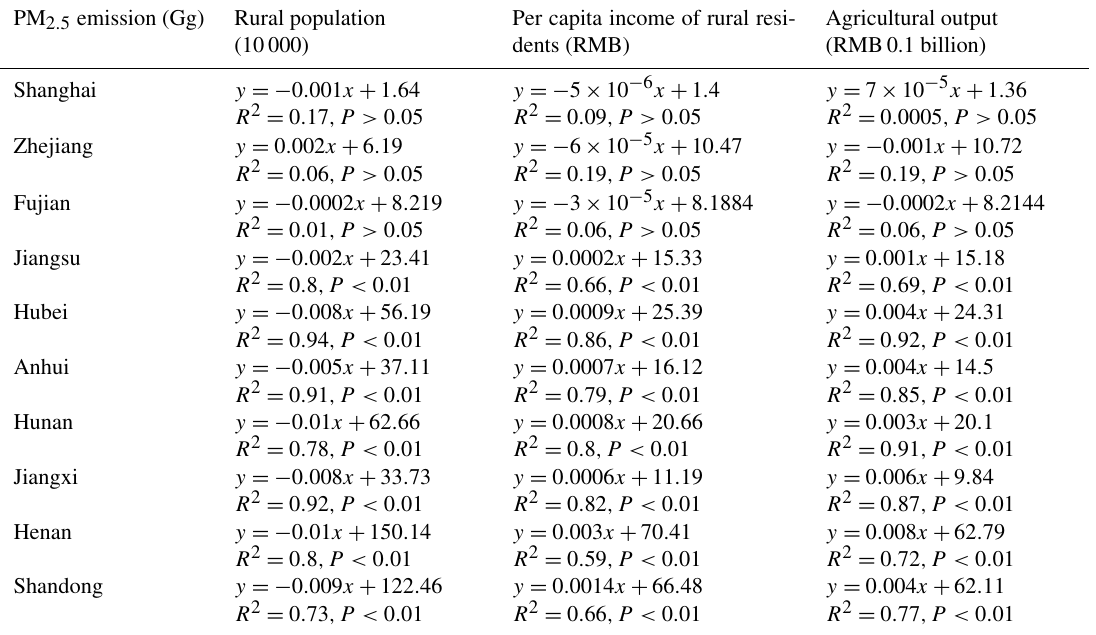
Figure 12. Correlation between PM 2 . 5 emissions from crop residue burning and agricultural output, rural population, per capita incomes of rural residents (a) and correlation between PM 2 . 5 emissions from forestry fire burning and forestry output, rural population, per capita incomes of rural residents (b) in different provinces from 2003 to 2015. Table 7. Correlation of the variation tendency between PM 2 . 5 emission from crop straw burning and rural population, agricultural output, per capita incomes of rural residents in each province from 2003 to